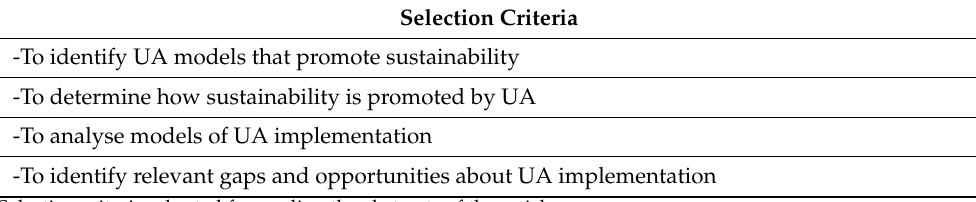
Table 1. Selection criteria.